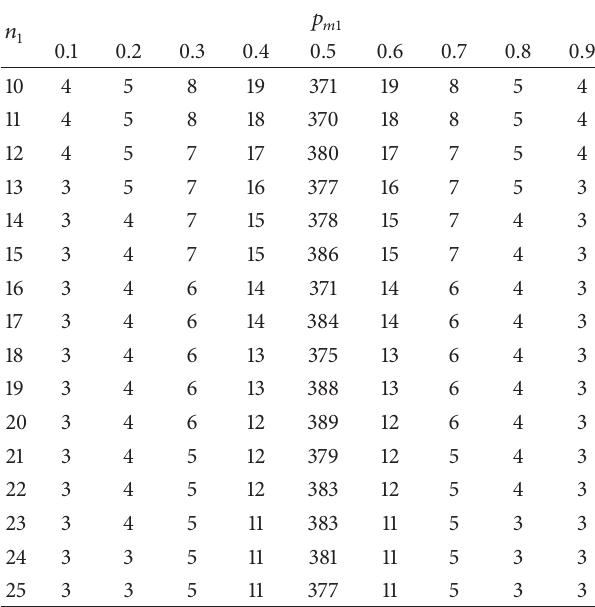
Table 5: The ARL 1 of the symmetric EWMA mean chart ( 𝜆 1 = 0.05 , = 0.5 with ARL ≈ 370 𝑝 𝑚0 𝑚0